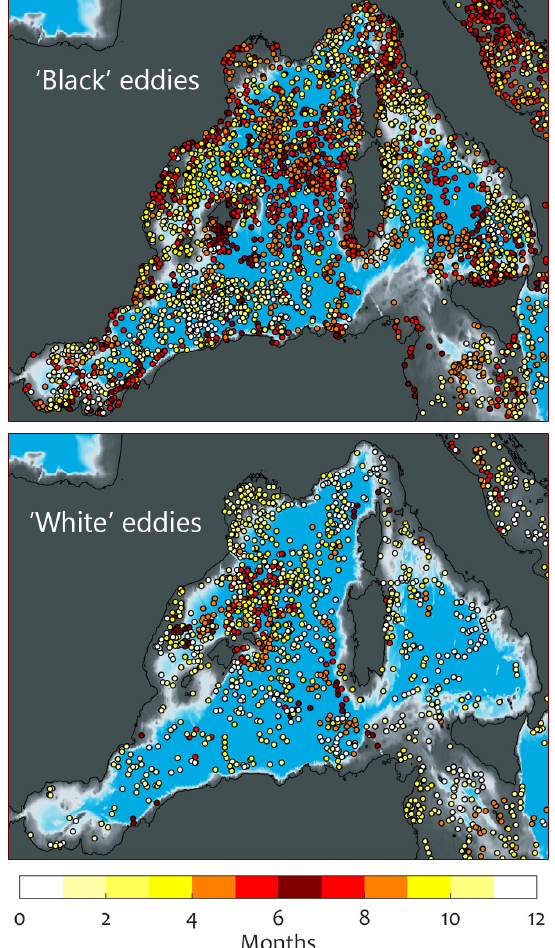
Figure 15. Spatial distribution of submesoscale eddies found